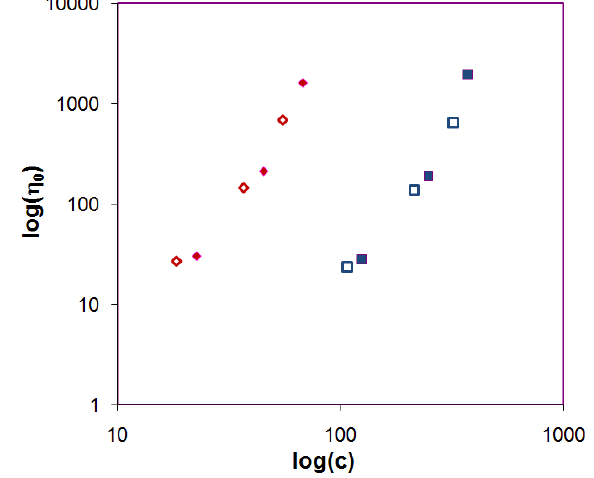
Figure 10. Zero shear viscosity plotted against concentration on a log-log scale for PEO 0.3 (open red diamonds), PEO 80:20 (filled red diamonds), dextran 500 (open blue squares) and dextran 50:50 (filled blue